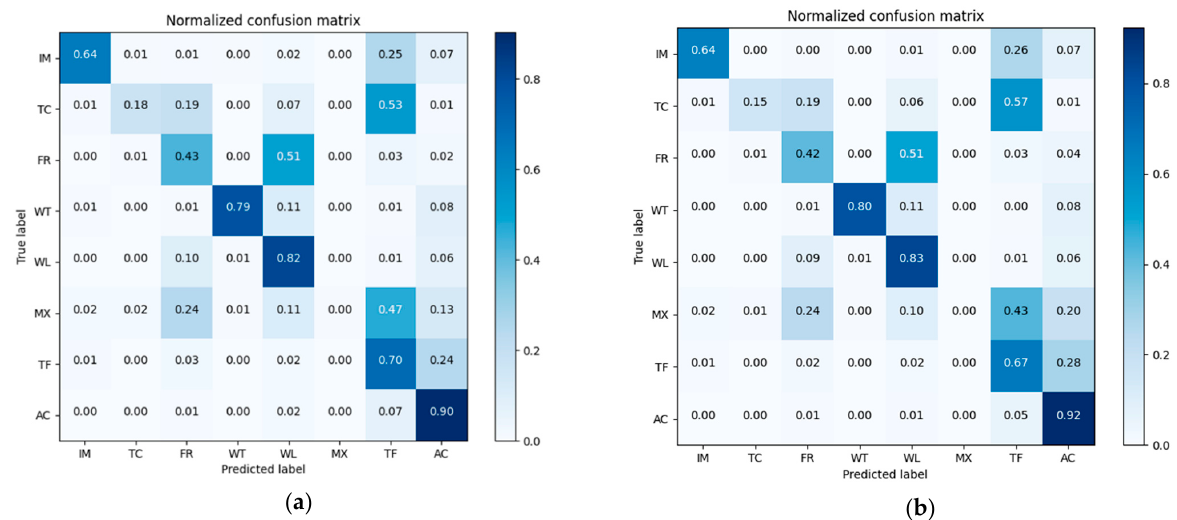
Figure 17. Confusion matrixes in Kent County for ( a ) pre-classification results and ( b ) the neighborhood spatial relationship and fuzzy classification fusion results.